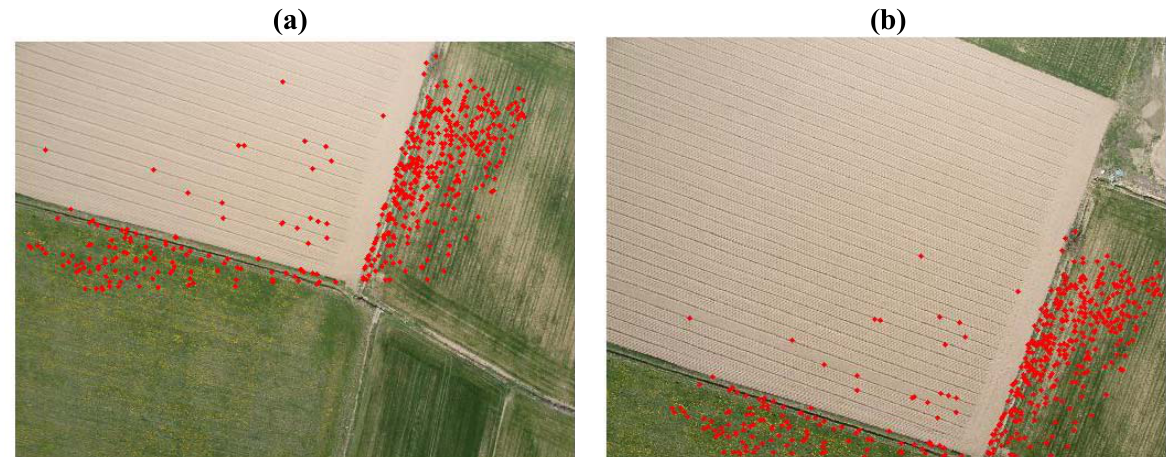
Figure 7. Villareggia Test 2. (a), (b) Image correspondences automatically matched by A 2 SIFT (487 points, L = 10).